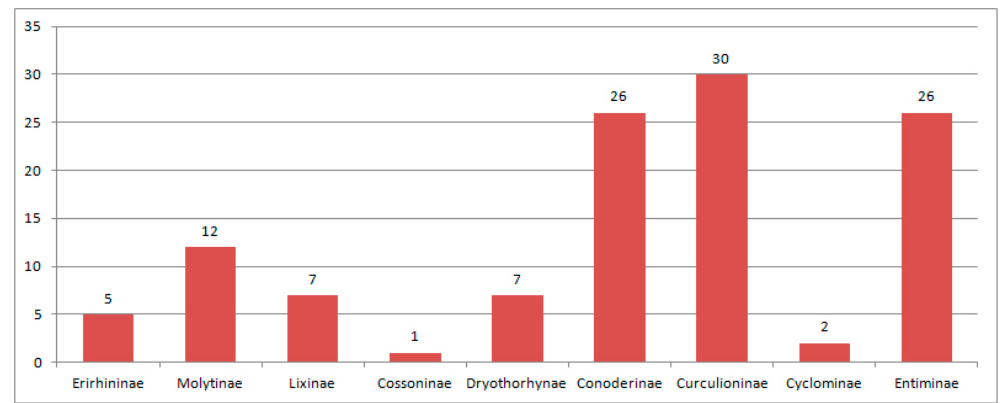
Figure 15. Composition of species of Curculionoidea in the Florissant.